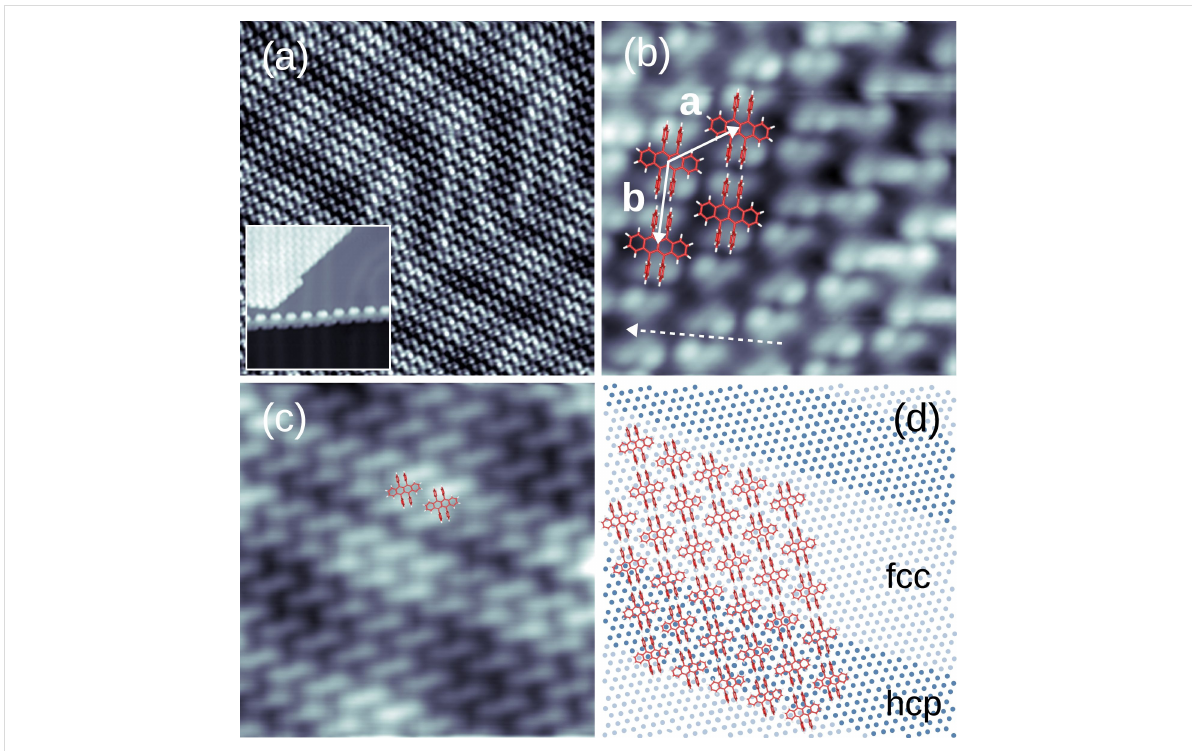
Figure 4: (a) STM image of C 42 H 28 molecules on Au(111) ( − 0.8 V, 50 pA, 30 × 30 nm 2 ). Inset: STM image of a Au(111) step edge decorated in a zig- zag manner with C 42 H 28 molecules on the top and bottom terrace ( − 2 V, 50 pA, 19 × 19 nm 2 ). (b) Close-up view of a molecular island ( − 0.65 V, 100 pA, 5 × 5 nm 2 ). Sketches of C 42 H 28 (to scale) are superimposed to facilitate the identification of individual molecules. The unit cell vectors a and b of the C 42 H 28 lattice are indicated as arrows. The dashed arrow marks a compact direction of Au(111). (c) Close-up STM image, which emphasizes the Au(111) reconstruction lines together with an additional periodic modulation of the apparent height along these lines (1 V, 50